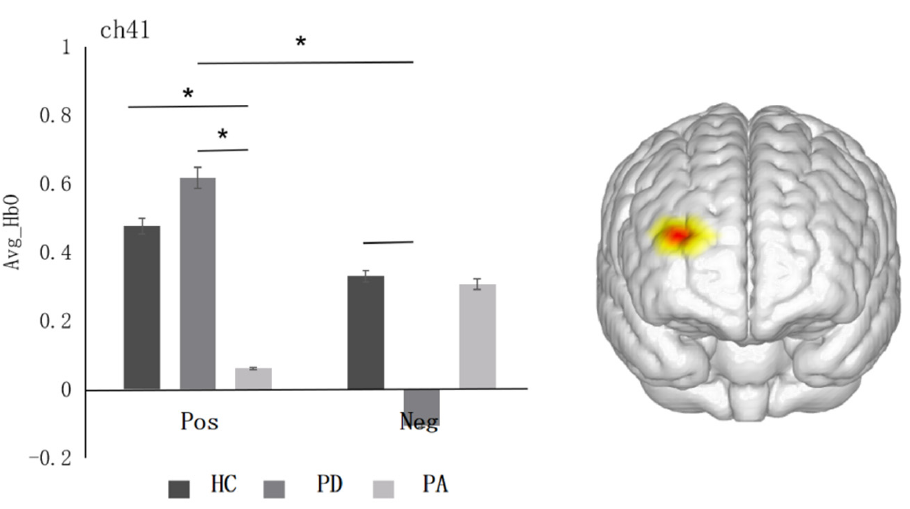
Figure 4. Histogram of the distribution of the average oxyhemoglobin in different emotions among three groups in ch41 (right dlPFC). *: p < 0.05.